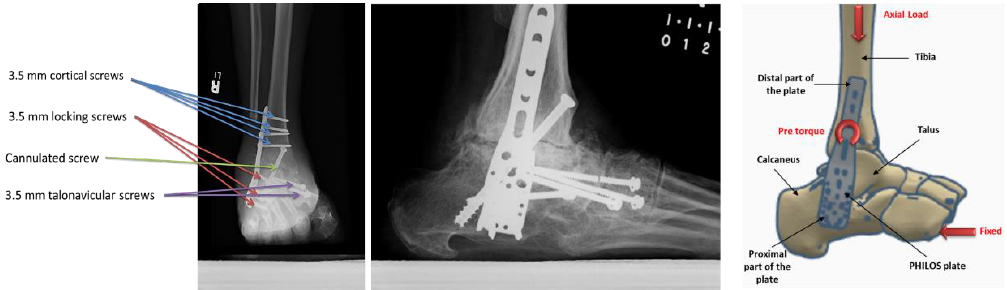
Figure 4. X-ray images of the PHILOS construct after two years showing the different types of screws used in fixation (cannulated and talonavicular screws were excluded from this study) ( left and middle ). The 3D model ( right ).